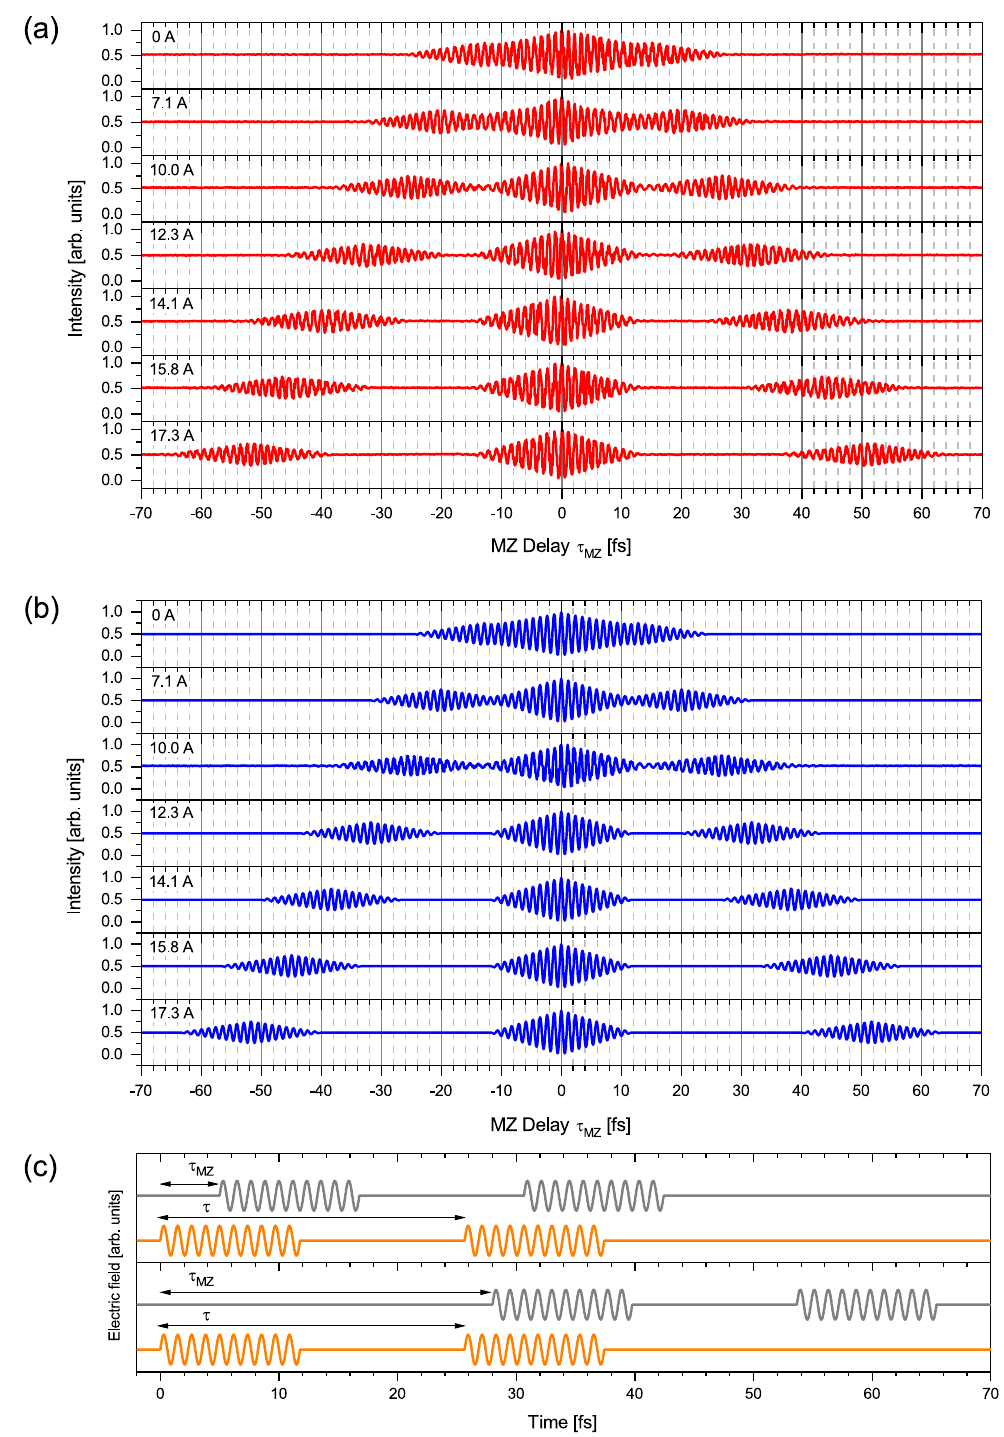
Figure 2. Autocorrelation measurements of spontaneous radiation from the tandem undulator at various values of the phase shifter current. The wavelength of the fundamental undulator radiation was set to 357 nm. ( a ) Measurement. ( b ) Calculation. ( c ) Waveform of the double pulsed wave packet (orange) and its delayed replica (gray) used in the calculation. As an example, the waveforms for a phase shifter current of 10.0 A is shown. The MZ delays are 5 fs and 28 fs in the top and bottom panels,